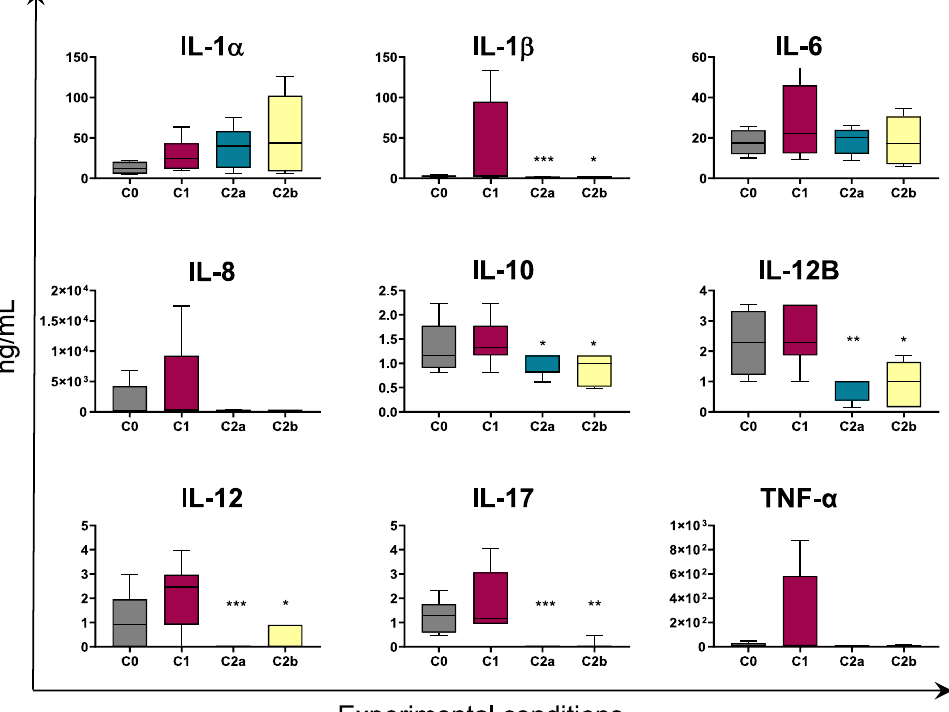
Figure 6. The 10 10 mEV impact on cytokine production by Caco-2. Caco-2 and THP-1 cells were left untreated (basal condition, C0) or stimulated with IFN- γ and LPS (inflamed co-culture, C1). At 24 h post stimulation, 10 10 mEV suspension was added to Caco-2 cells in inflamed co-culture (C2a) or to both Caco-2 and THP-1 cells in inflamed co-culture (C2b). A total of 24 h later, culture supernatants were collected, and levels of cytokines were determined through ELISA. Data are presented as box-and-whisker plots displaying median and interquartile range (boxes) and minimum and maximum values (whiskers). Values of C0, C2a, C2b were compared to C1, using an ANOVA followed by Dunnett’s multiple comparison test or a Kruskal–Wallis test followed by Dunn’s multiple comparison test; * p < 0.05, ** p < 0.01 and *** p < 0.001.